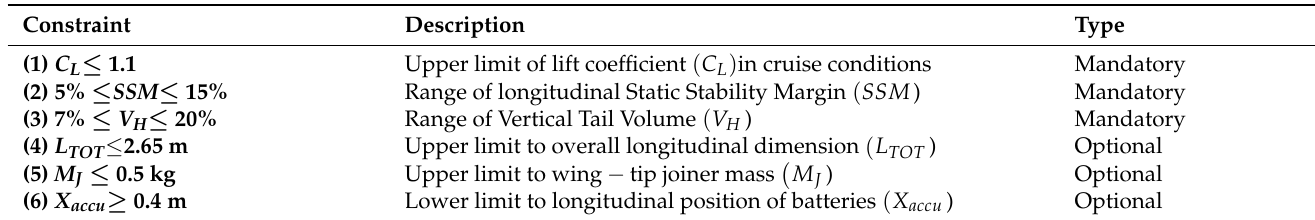
Table 3. Example of set of constraint implemented in SD2020